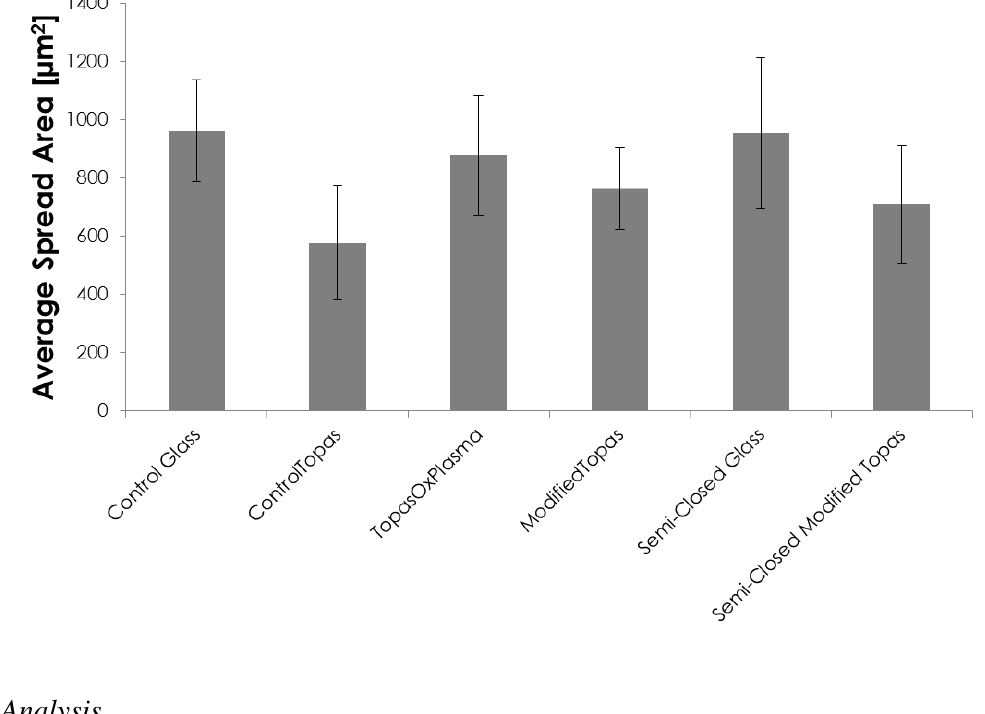
Figure 4. The graph presents the results of the analysis of average spread area on each tested sample. As a control the spread area was measured on a glass slide and untreated Topas (cid:114) showing a much higher area on the hydrophilic glass surface. The treatment of Topas (cid:114) with oxygen plasma resulted in an average spread area comparable to glass. Topas (cid:114) modified with combined technique had a lower average spread area than glass but with a big improvement as compared to untreated Topas (cid:114) . Both semi-closed devices performed equally well as the respective slides open to ambient air indicating a successful fixative